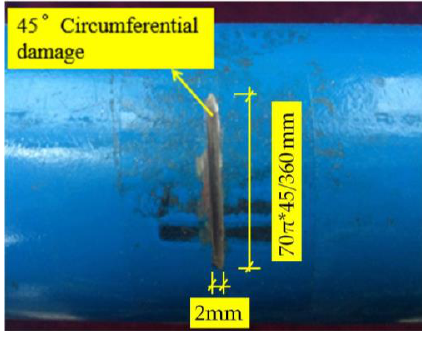
Figure 23. Artificial circumferential damage with the radius angle of 45° in detail.